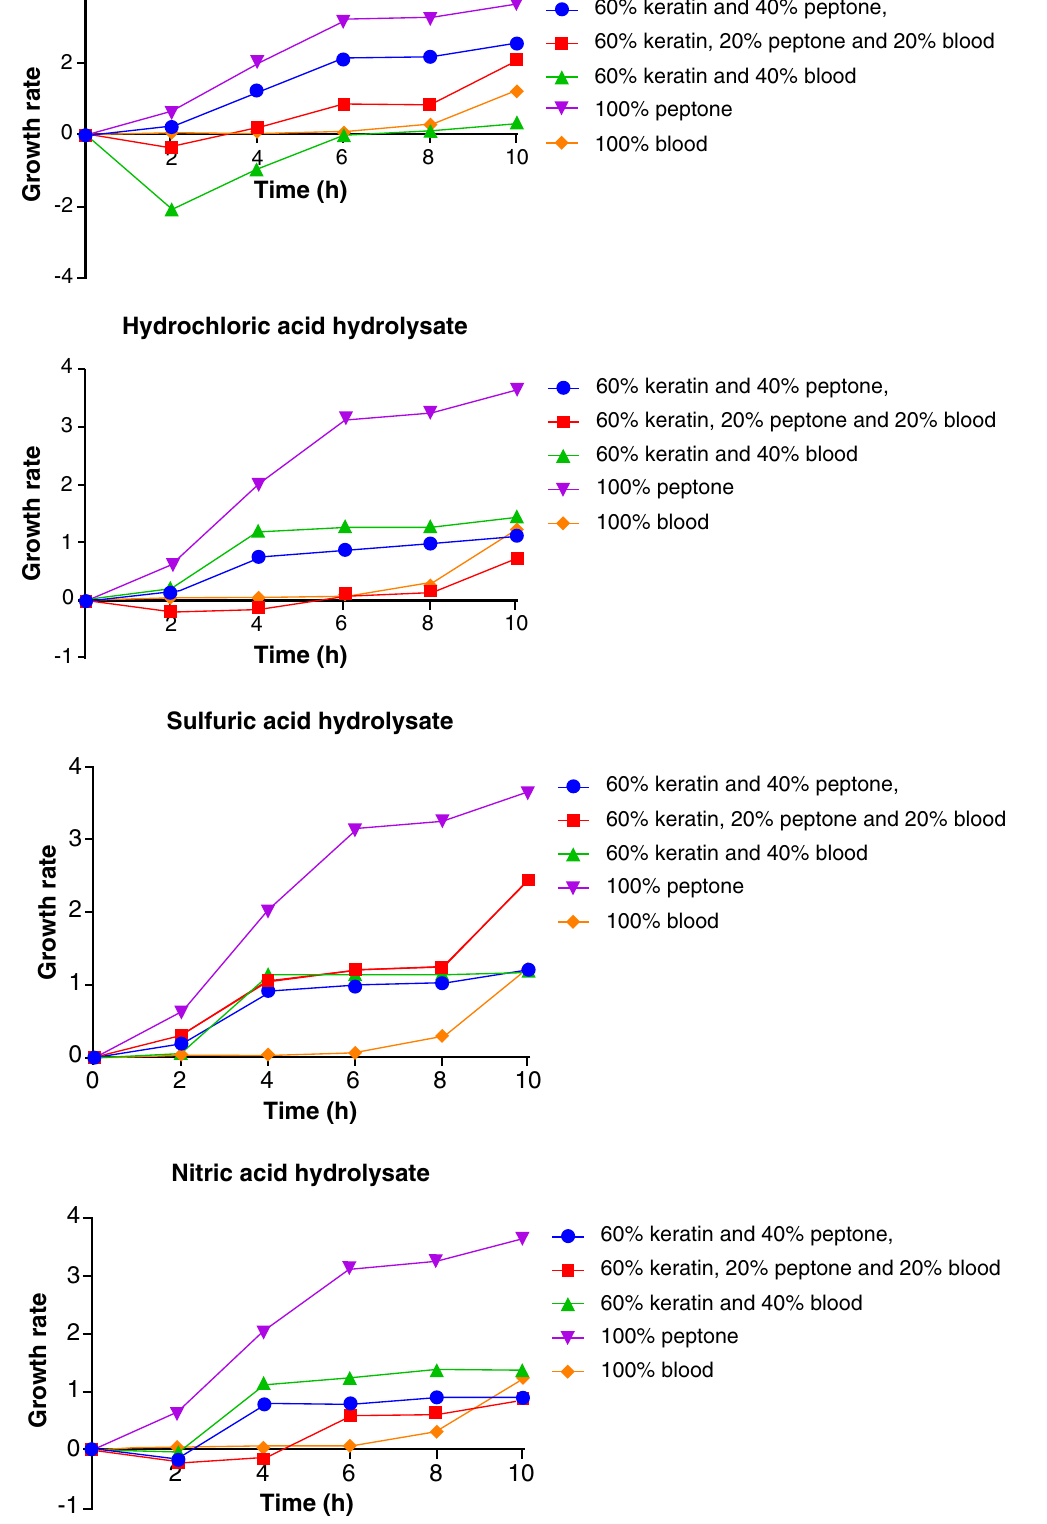
Figure 8. Growth rate of Staphylococcus aureus in media with TCA, HCl, H